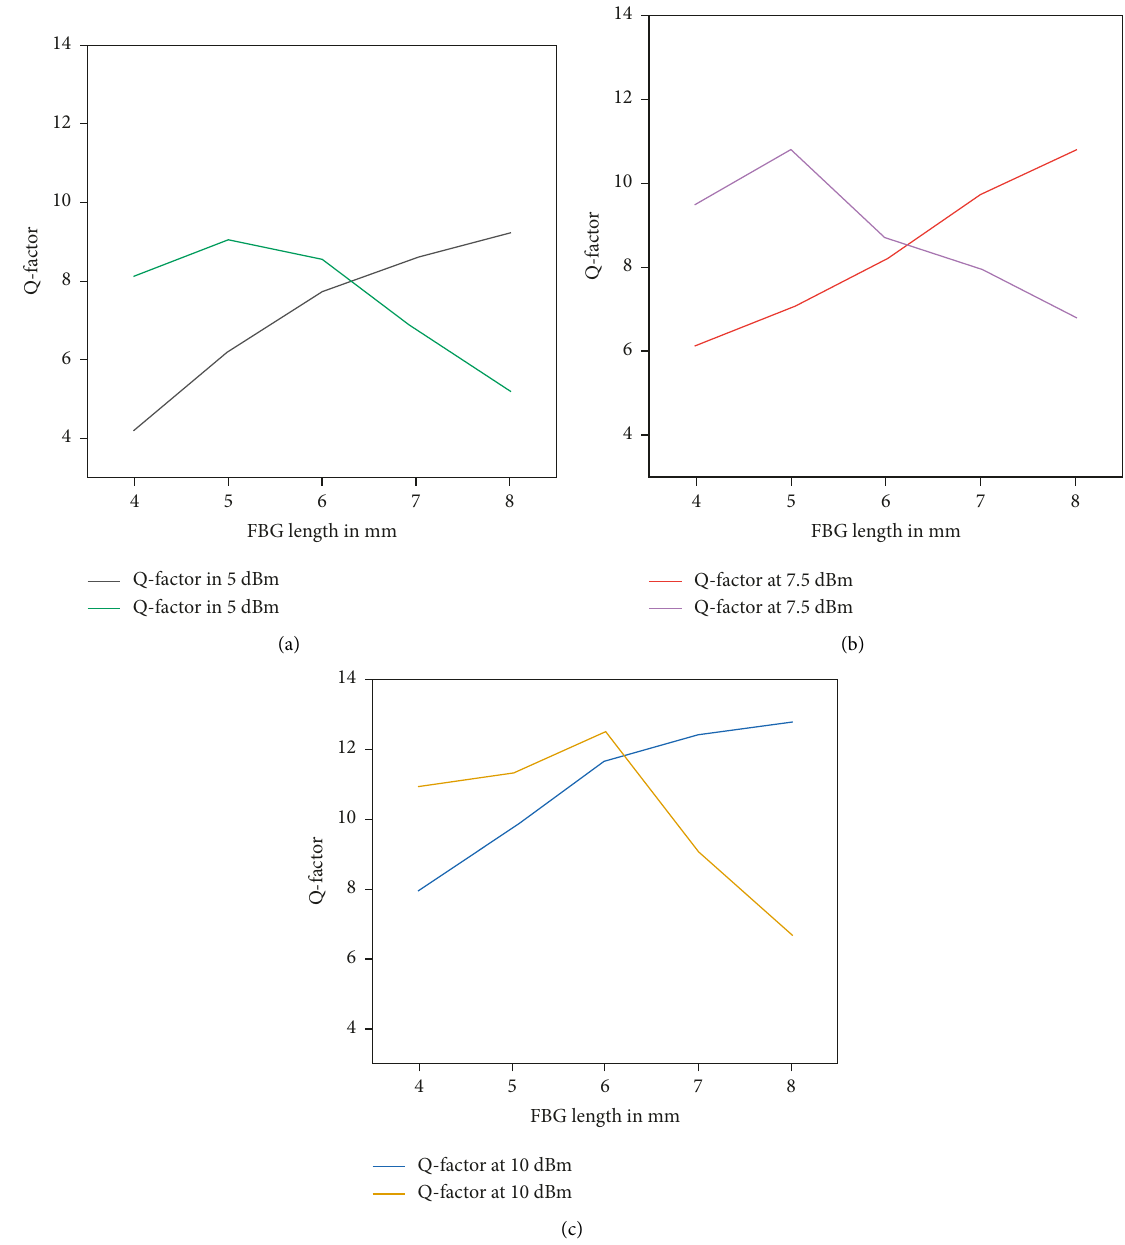
Figure 6: Comparison of linear Gaussian versus linear tanh profile 4 FBG+DCF. (a) for 5 dBm, (b) for 7.5dBm, (c) for